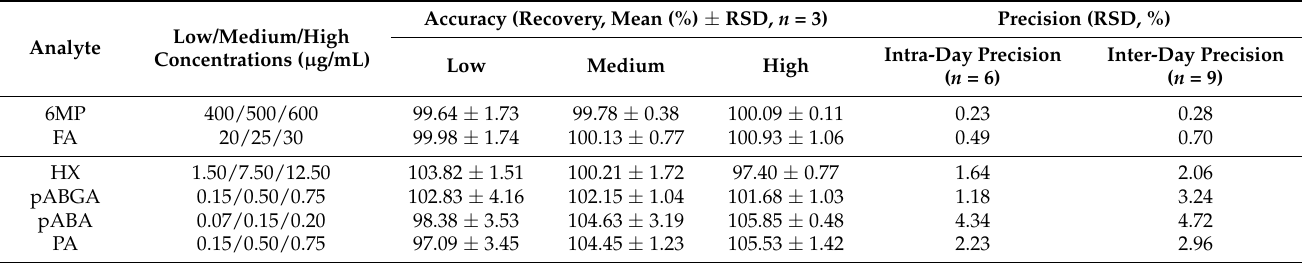
Table 2. Accuracy and precision of the developed high-performance liquid chromatography (HPLC) method. RSD: relative standard deviation.